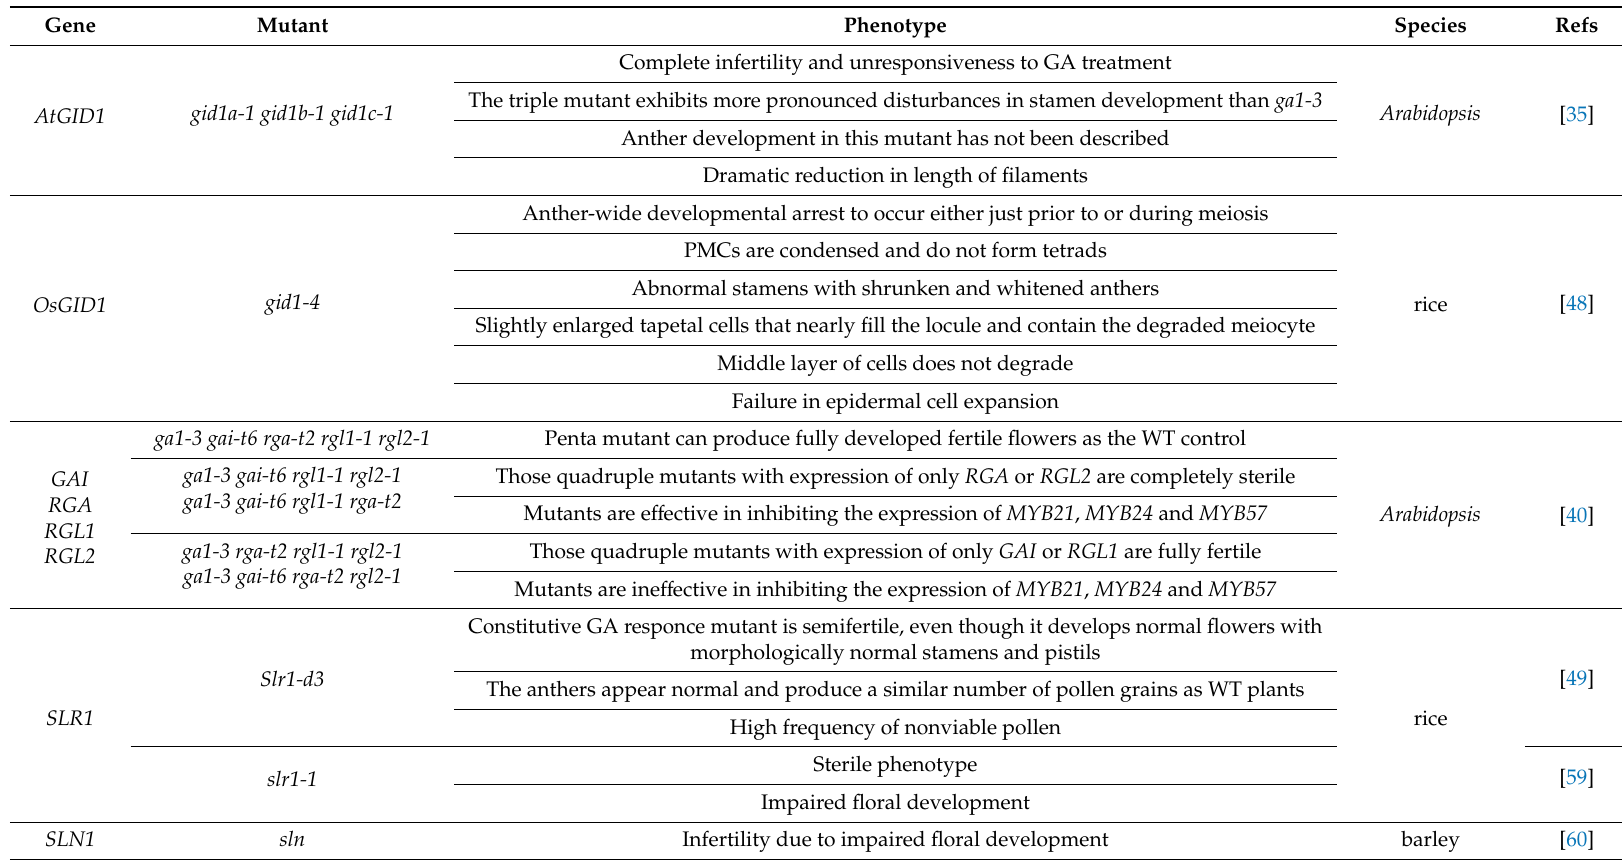
Table 2. Stamen-related features of GA responsive mutants. GA INSENSITIVE DWARF1 (GID1); GA INSENSITIVE ( GAI ); REPRESSOR OF GA1-3 ( RGA );